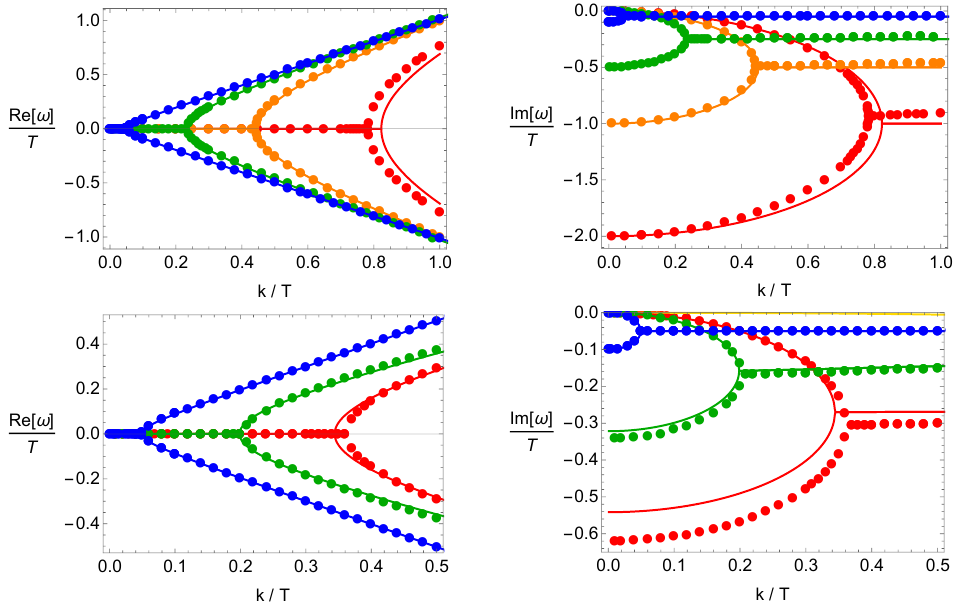
Figure 13 . Top: the dynamics of the EM waves at zero density and zero magnetic field. Different colors, from blue to red, correspond to λ/T = (0 . 1 , 0 . 5 , 1 , 2) . The imaginary part of the non- hydrodynamic mode at k = 0 is given analytically in eq. (4.14). Bottom: the dynamics of the EM waves at zero density and λ/T = 0 . 1 . Different colors, from blue to red, correspond to B/T 2 = (0 , 7 , 10)